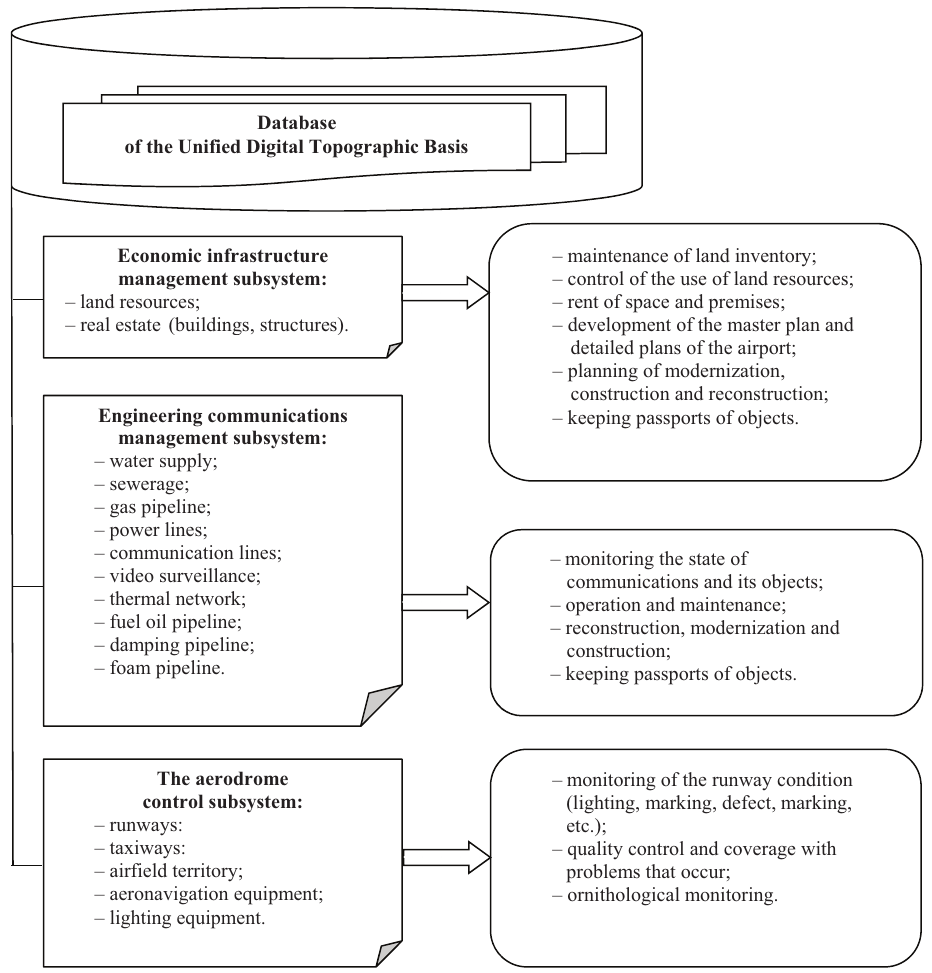
Figure 5. Conceptual model of structure and functional purpose of geoinformation system for administrative and economic management of the